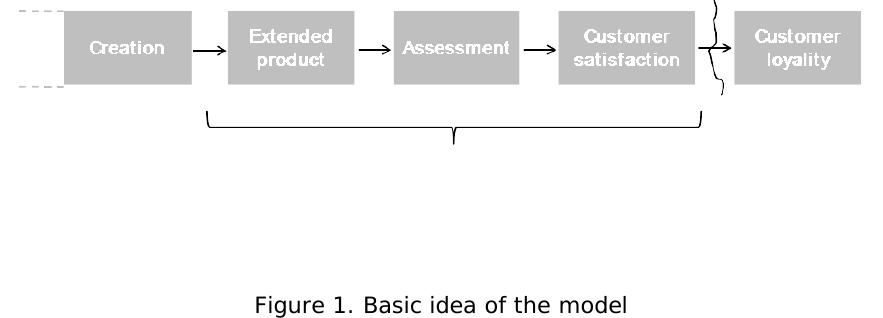
Figure 1. Basic idea of the